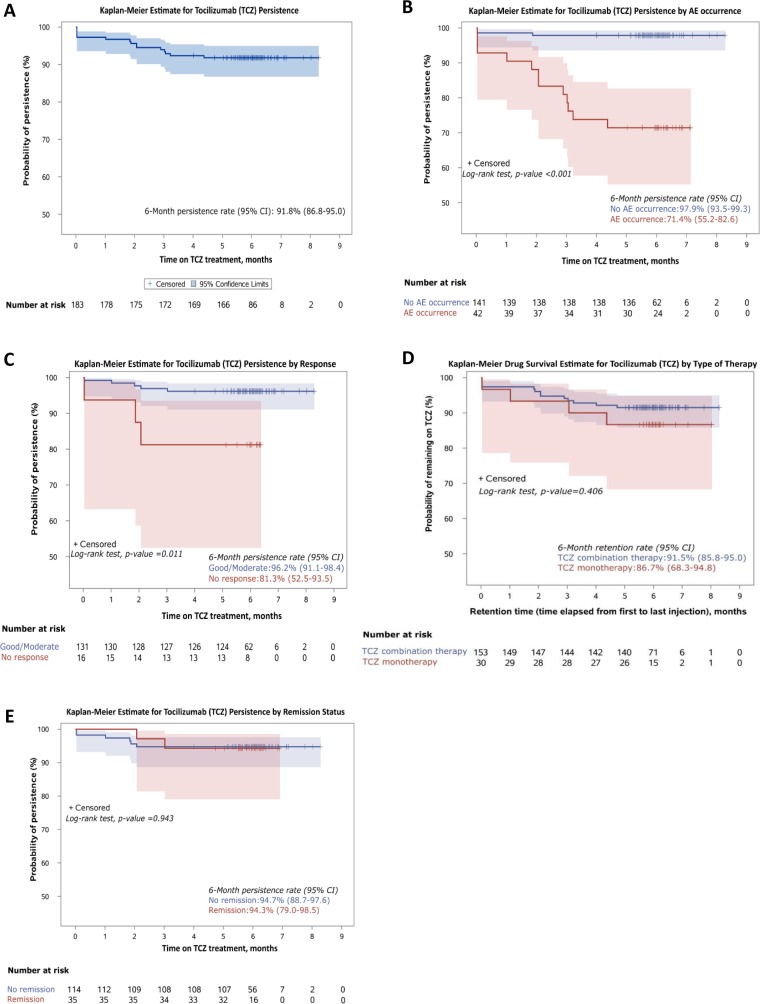
Kaplan-Meier estimate of persistence to Tocilizumab therapy at 6 months of A) the whole cohort and by B) adverse event occurrence, C) response, D) type of therapy, E) remission status.